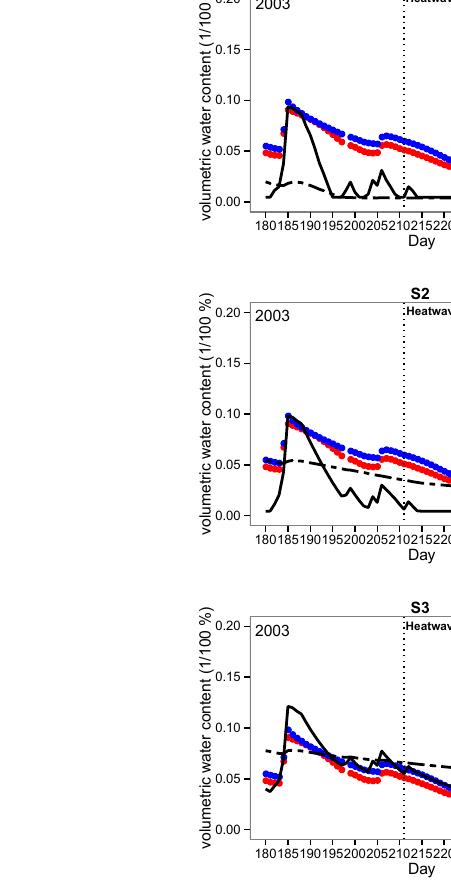
Figure 9. Daily modelled (mod, black lines) and observed (obs, red and blue) soil moisture (as volumetric water content, 1 / 100%) for summer of 2003 and 2005. The two depths refer to the two soil layers in LPJ-GUESS: l 1 (0–50cm) and l 2 (50–150cm). For 2003, the heatwave period is indicated between the black